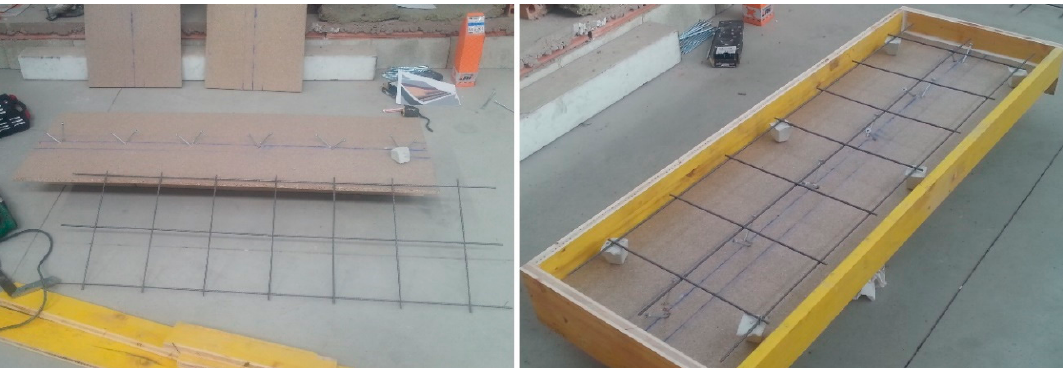
Figure 5. Final appearance of the mesh and formwork of the constructive unit. Table 5. Mortar dosages for the 70 L mixer